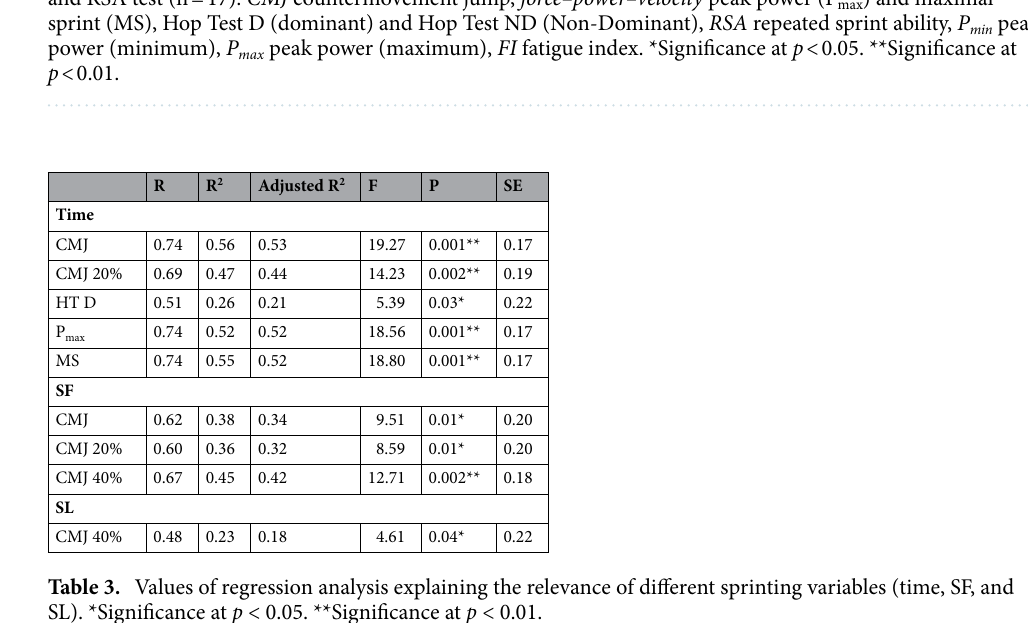
Table 2. Pearson correlation coefficient between sprinting variables and force–power–velocity, CMJ, hop test and RSA test (n = 17). CMJ countermovement jump, force–power–velocity peak power (P max ) and maximal